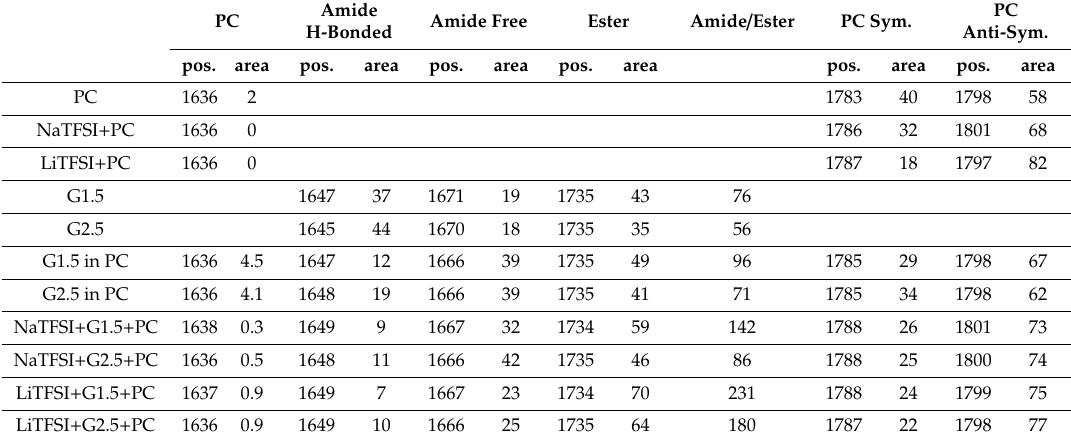
Table 3. Positions and areas normalized to the summary area of bands connected with the component, to which the vibration belongs. Carbonyl stretching